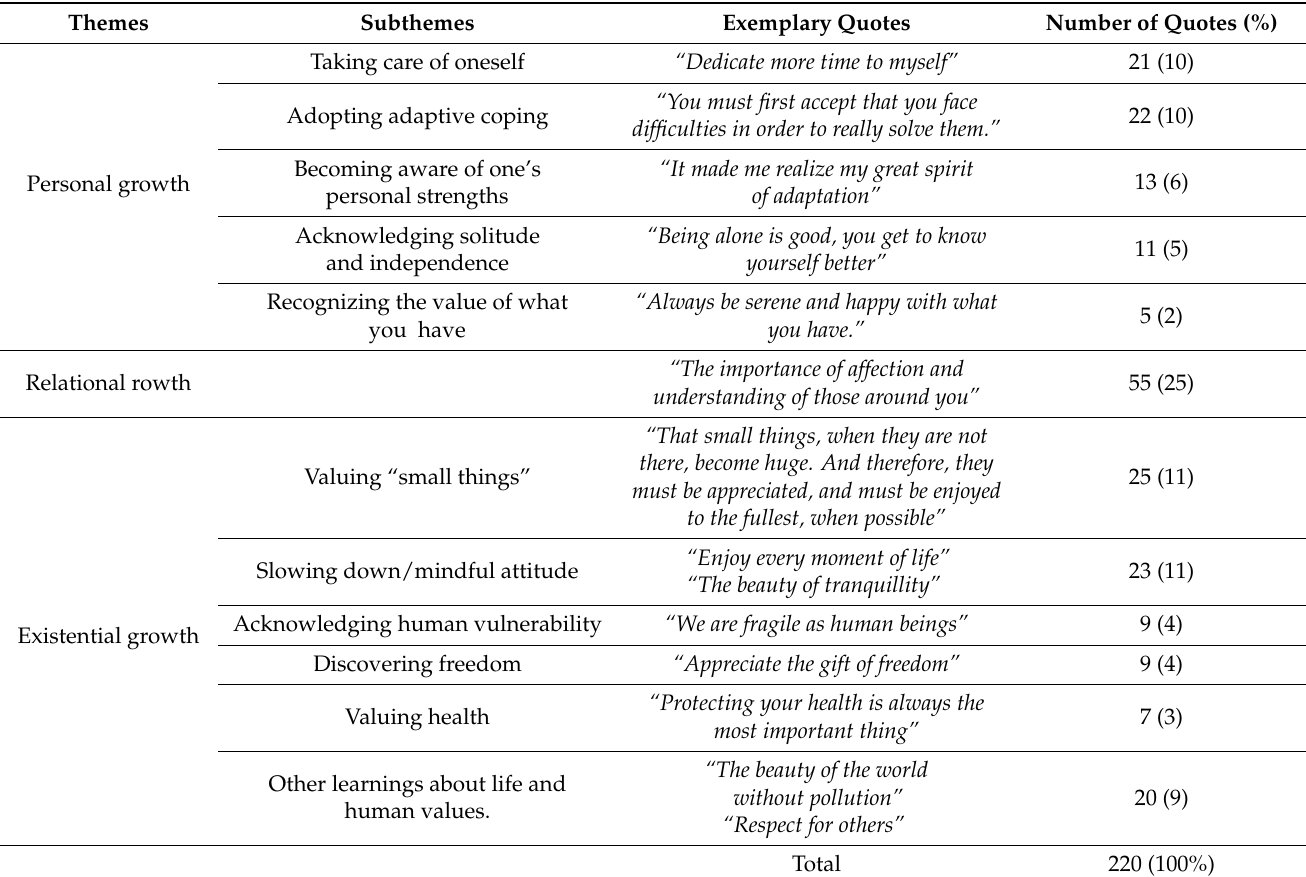
Table 1. Frequencies of themes and